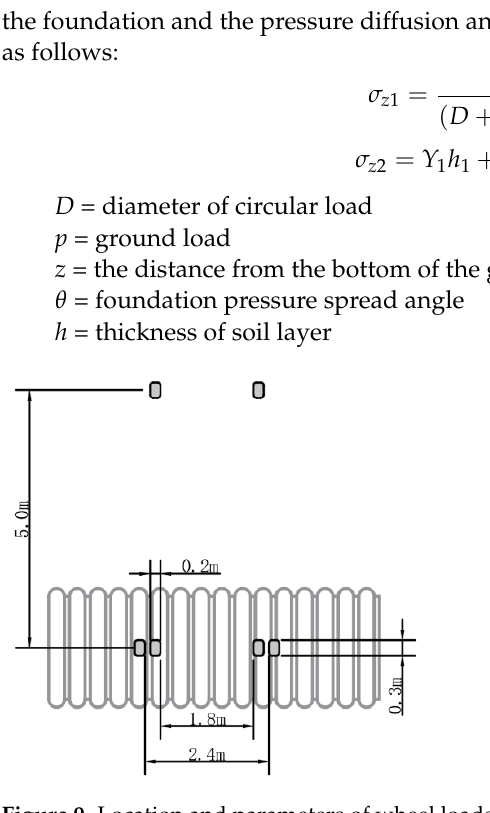
( b ) ( c ) Figure 11. Circumferential strain of pipes. ( a ) Crest; ( b ) Valley; ( c ) Liner.